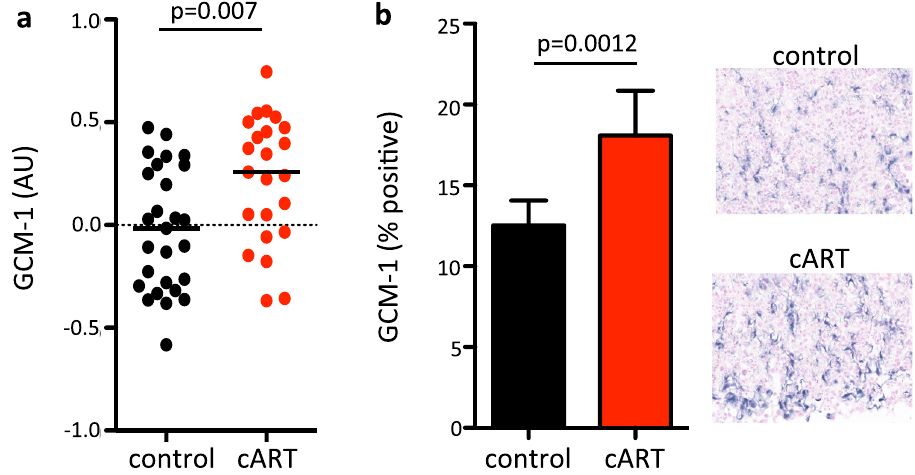
Figure 3. cART exposure during pregnancy is associated with an increase in Gcm-1 expression in the placenta. ( a ) Gcm-1 mRNA expression in the placenta of control (black) and cART-treated (red) mice assessed by qPCR. Data are log transformed and shown as scatter plot with median. Statistical comparison by Mann Whitney U test. n = 27 placentas from 10 dams for control and n = 23 placentas from 8 dams for cART. ( b ) Gcm-1 expressing cells in the labyrinth zone of the placenta of control (black) and cART-treated (red) mice, assessed by in situ hybridization. Representative in situ images are shown on the right. Control is shown on the top and cART-treated on the bottom. Data are mean with standard deviation. Statistical comparisons using Student’s t-test. n = 6 placentas from 3 dams for control and n = 7 placentas from 4 dams for